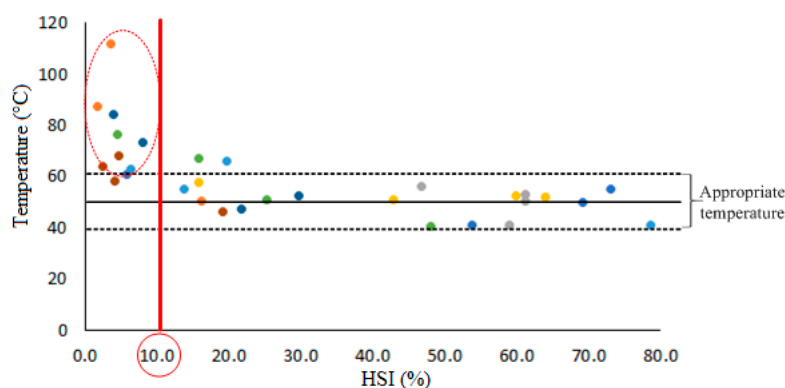
Figure 18. Example of resin deformation of defect cell: ( a ) HSI of this cell is 0% and the temperature reached 136 °C; ( b ) Resin deformation occurred at the edge of the defective cell.